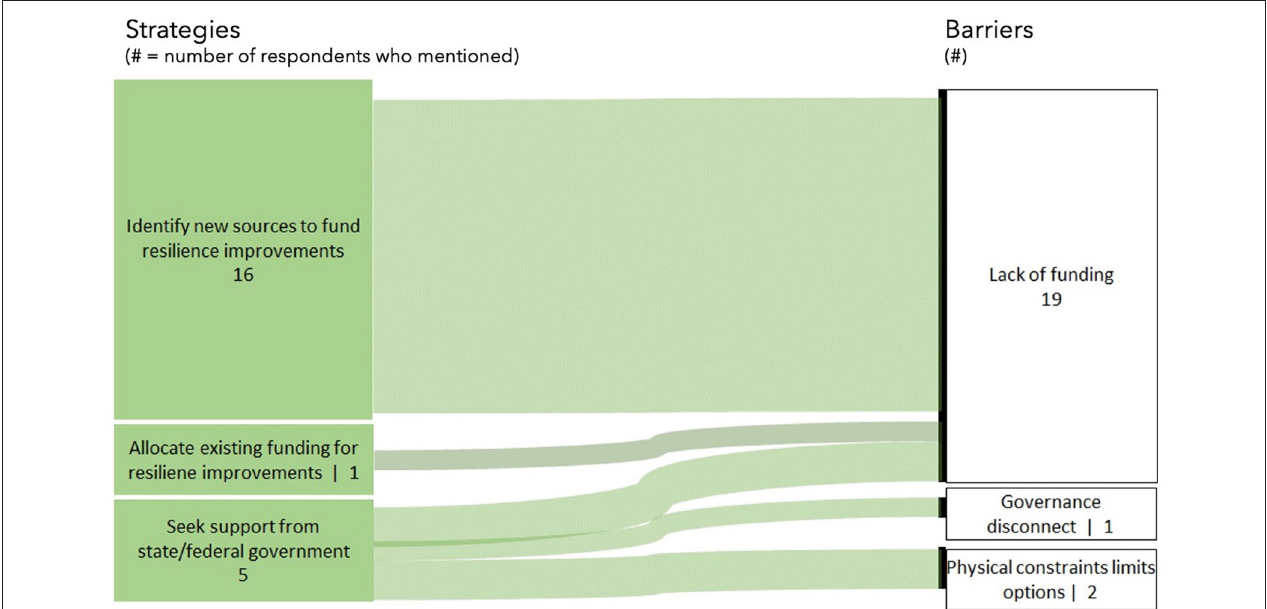
FIGURE 3 | Funding strategies (left side) to overcome identified barriers (right side).